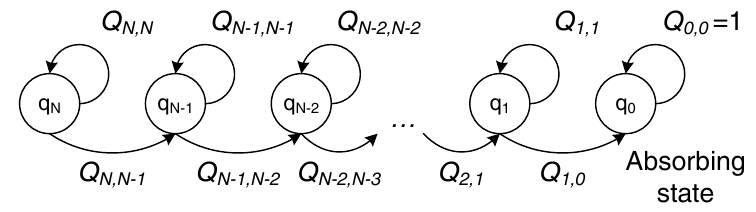
Figure 8. Absorbing Markov chain model for the relaying